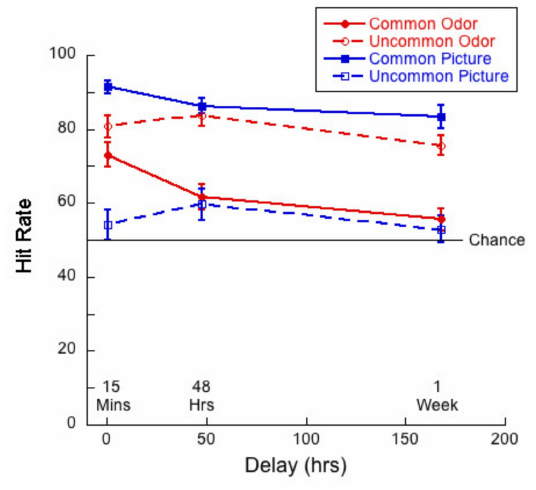
Figure 5. Hit rate as a function of delay for each of the four test conditions. A 2 (commonness) × 3 (delay) mixed ANOVA of hit rates for the picture stimuli revealed no significant interaction ( F (2,83) = 1.61; p = 0.21, η 2 = 0.04). There was a signif- icant main effect of commonness ( F (1,83) = 161.59, p < 0.01, η 2 = 0.66), but not of delay ( F (2,83) = 1.09, p = 0.34, η 2 = 0.03). Thus, hit rates were significantly higher for common than uncommon pictures, but did not decline significantly over one